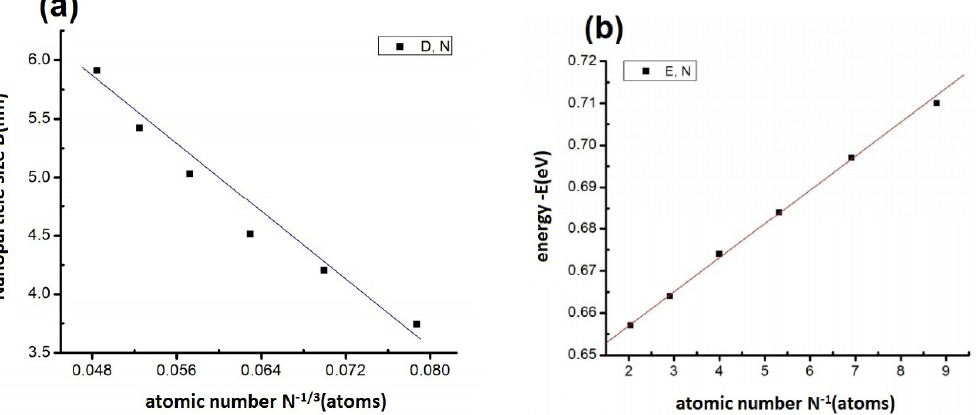
Figure 4. The correlation between the D and the N ( a ), and the correlation between the E and the N ( b ) of amorphous Ni materials with different atomic numbers. ( b ) of amorphous Ni materials with different number of